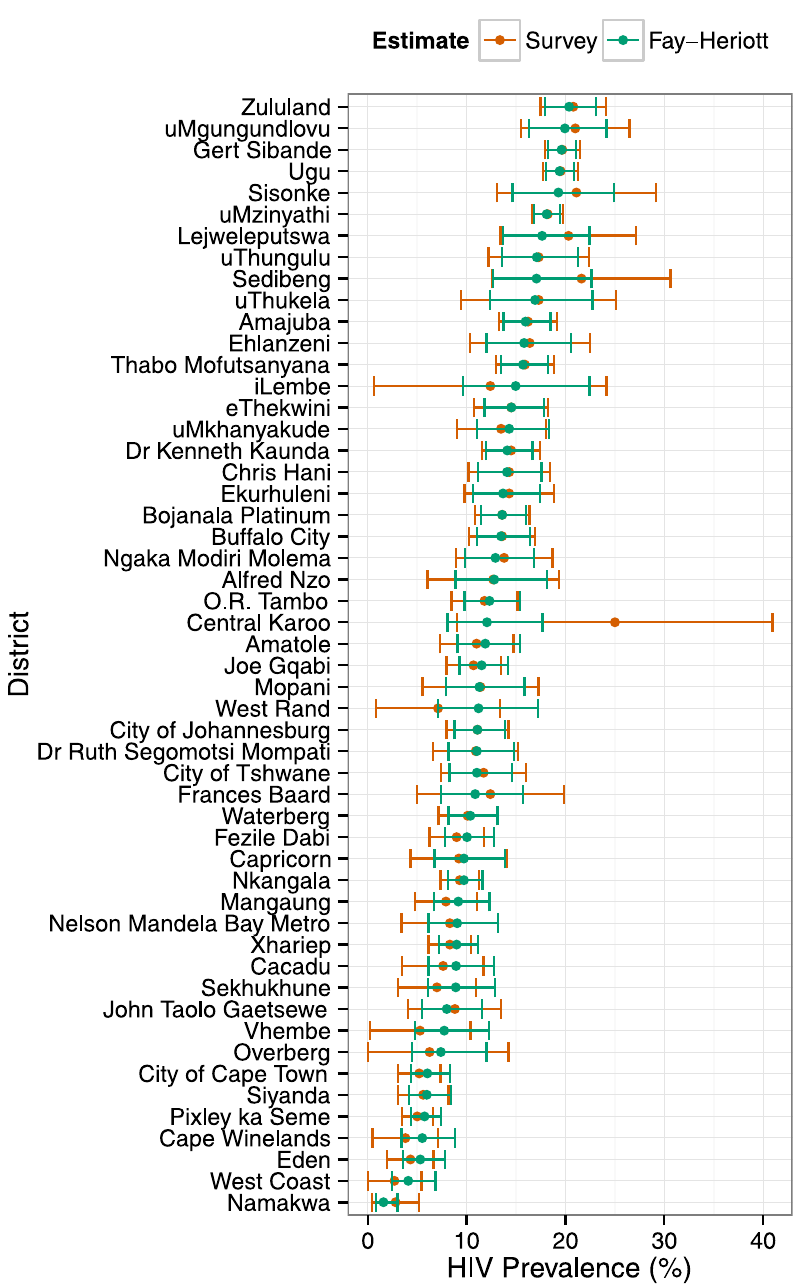
Numeric values are provided in S2